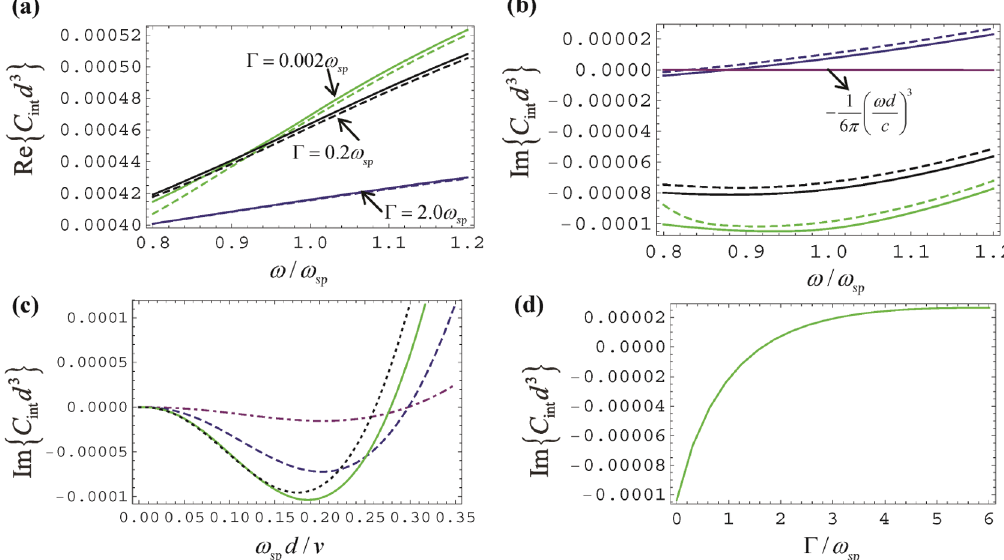
FIG. 2. (a) Real part and (b) imaginary part of the interaction constant as a function of frequency for a point dipole placed at a distance d ¼ 1 nm ( ω d=c ¼ 0 . 0135 ) above a silver semispace in relative motion. The relative velocity of the silver semispace is sp v ¼ 5 . 26 ω d ¼ 0 . 07 c . Green lines: Γ ¼ 0 . 002 ω ; black lines: Γ ¼ 0 . 2 ω ; blue lines: Γ ¼ 2 . 0 ω . The solid lines represent the sp sp sp sp nonrelativistic calculation [Eq. (13)] and the dashed lines represent the exact relativistic calculation. (c) Imaginary part of the interaction d=v in the nonrelativistic lossless limit ( Γ ¼ 0 þ ). Purple dot-dashed line: ω ¼ 0 . 1 ω constant as a function of ω ; blue dashed line: sp sp ω ¼ 0 . 5 ω ; green solid line: ω ¼ 1 . 0 ω ; black dotted line: ω ¼ 1 . 1 ω . (d) Imaginary part of the interaction constant at ω ¼ ω sp sp sp sp d ) as a function of the normalized collision frequency Γ in the nonrelativistic limit [Eq. (for d ¼ 1 nm and v ¼ 5 . 26 ω sp